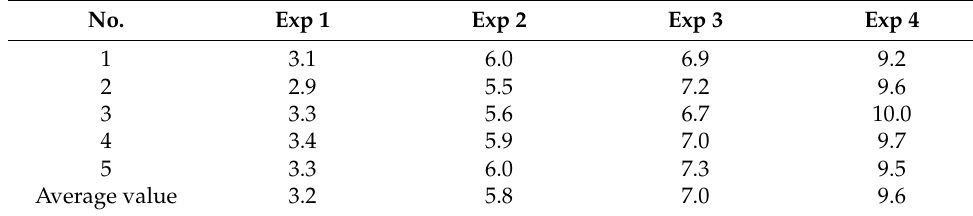
Table 3. Hydrogen flow rate (mL/min) measurement for each